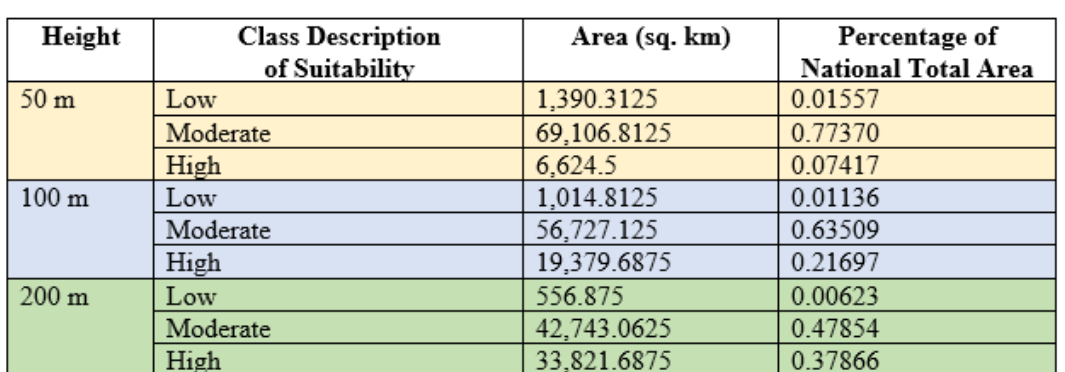
Figure A1. Suitable classes and land areas for wind energy at the three heights (50-m, 100-m, and 200-m) for Jordan.